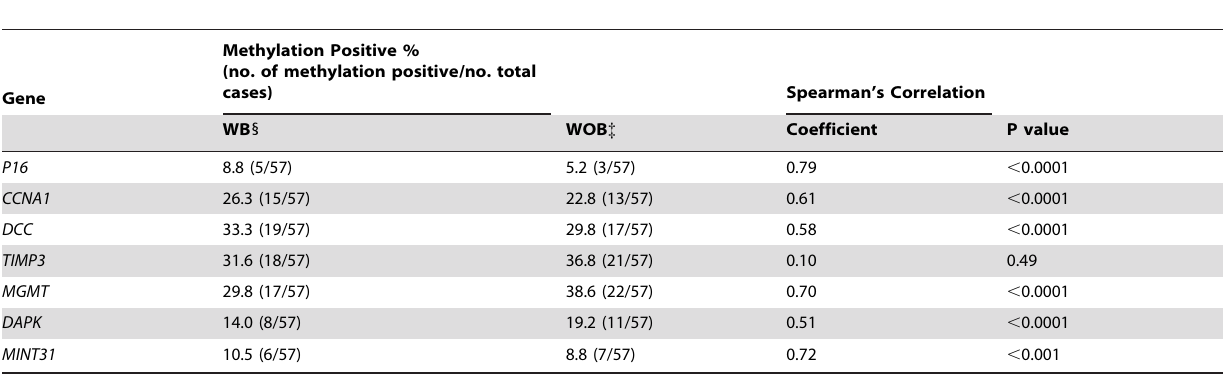
Table 2. Frequency of promoter methylation of the seven genes analyzed in the salivary rinses collected with or without an exfoliating brush from 57 HNSCC patients, and Spearman correlation of promoter methylation levels.